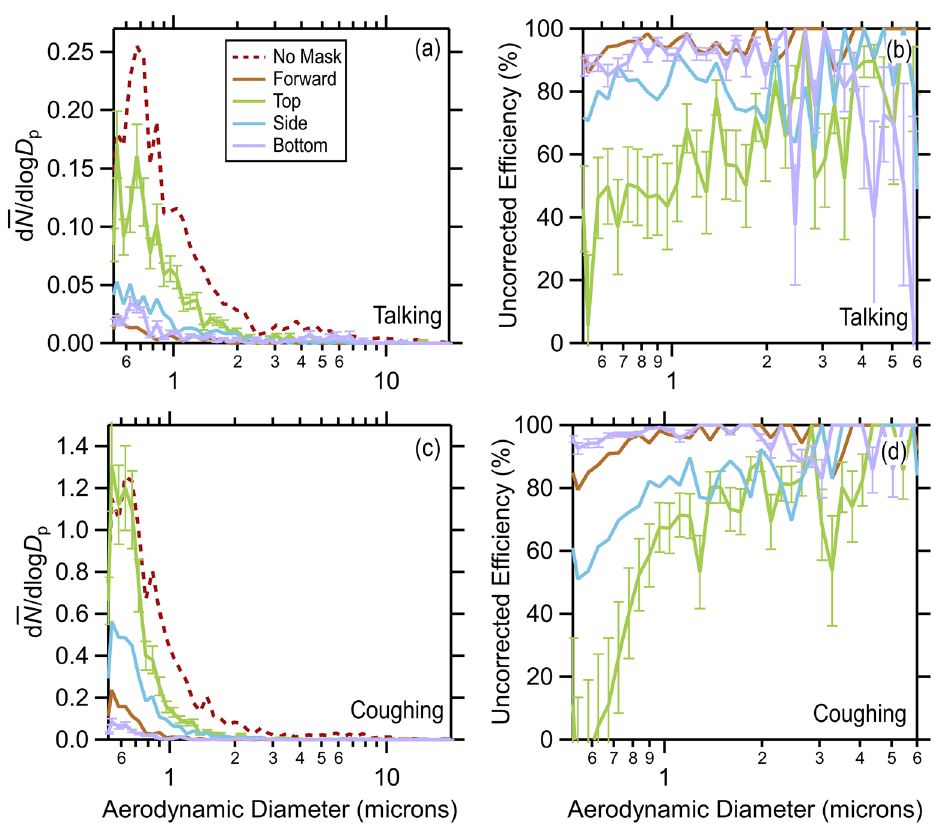
Figure 3. Average particle size distributions observed for no mask and the four orientations (forward, top, side, bottom) when masked for ( a ) talking and ( c ) coughing and the resulting size-dependent particle reduction efficiencies, uncorrected for flow, for ( b ) talking and ( d ) coughing. Error bars are based on repeat ( N = 10, standard error of the mean) size distribution measurements from one participant for talking made over multiple days, and are shown for the top and bottom orientations, as